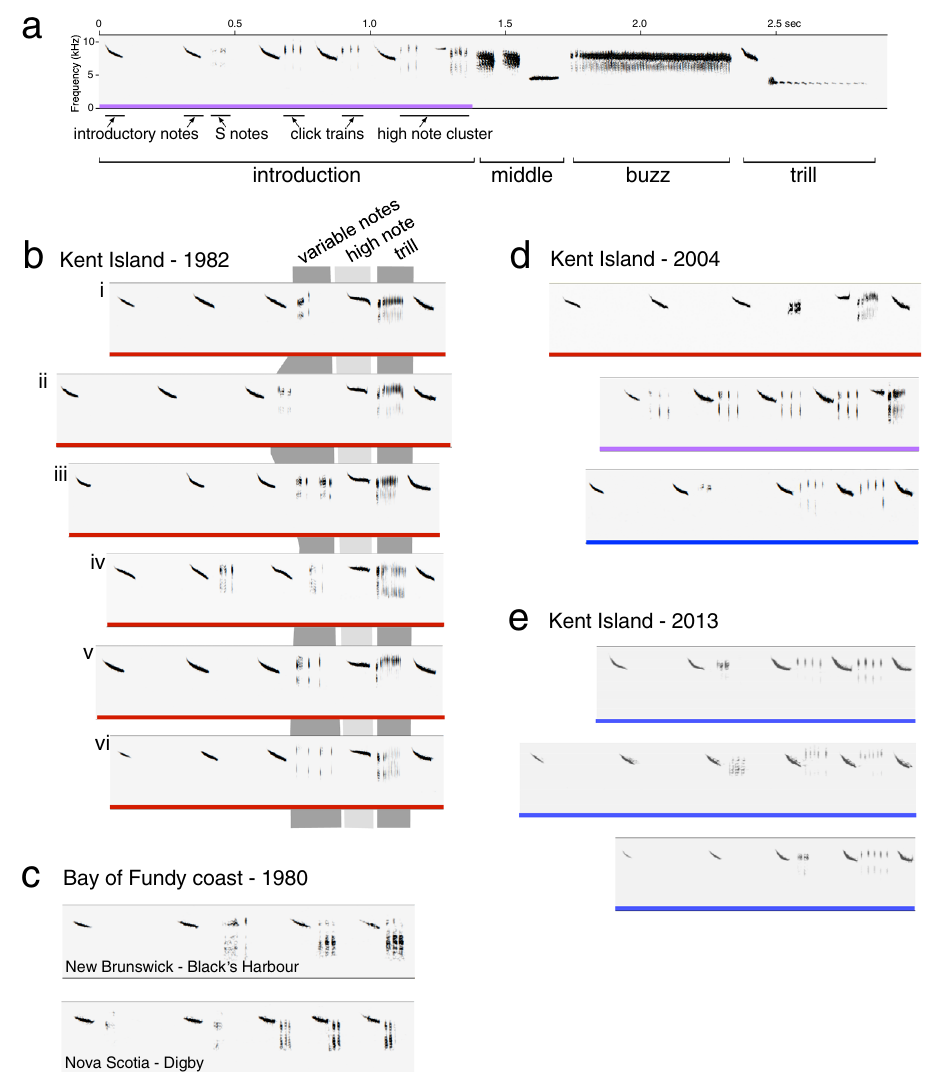
Fig. 2 Sound spectrograms of Savannah sparrow song and introductory segment features. a Savannah sparrow song, showing all segments.